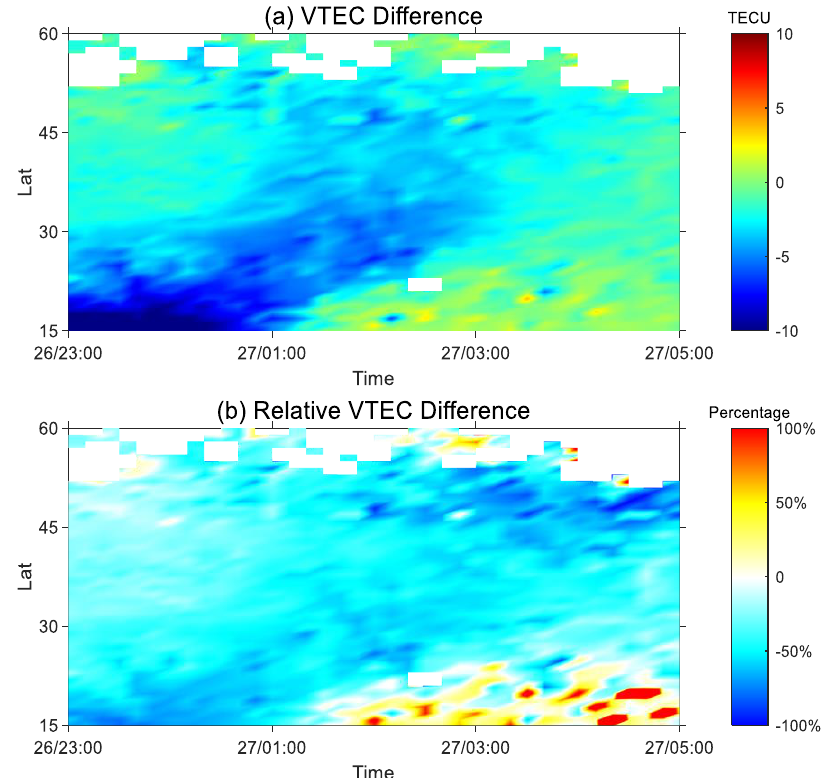
Figure 8. Latitude/time variation of ( a ) VTEC difference and ( b ) relative VTEC difference of storm-3 from 15°N to 60°N at 90°W.